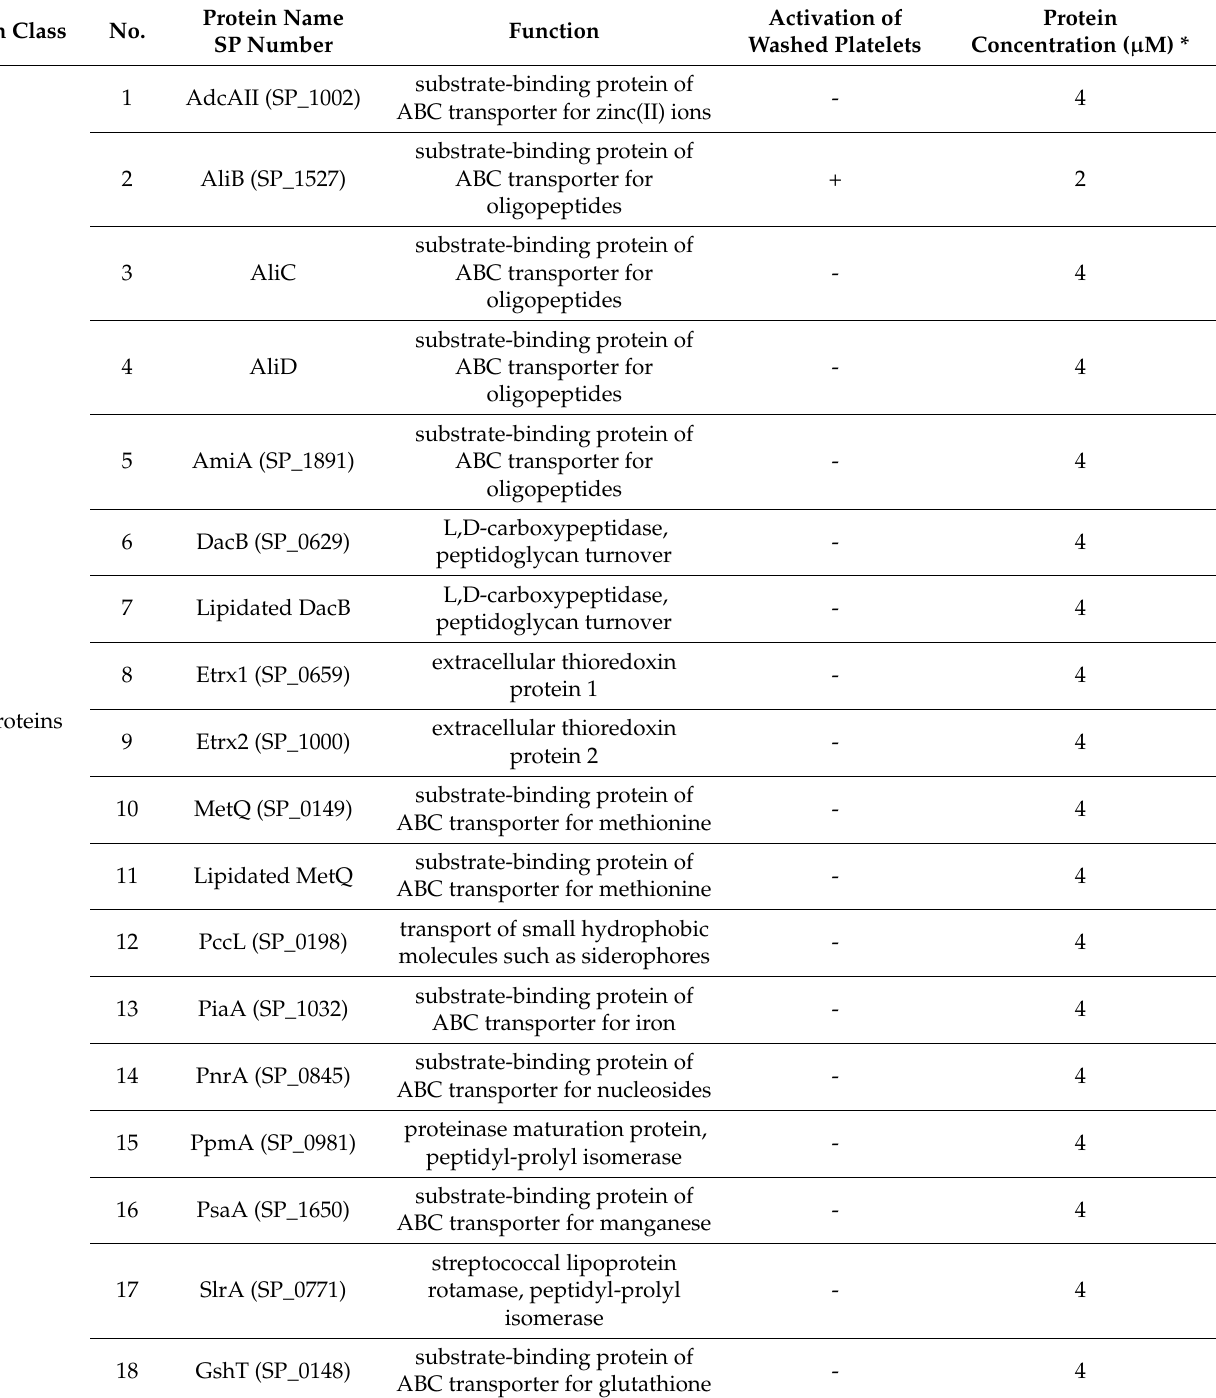
Table 1. List of pneumococcal proteins and cell wall components, which were tested to activate platelets and led to CD62P expression. * The last column provides the highest tested concentration of each protein in the platelet activation assay. The molarities were chosen on the basis of previous publications determining platelet activating potential of bacterial proteins